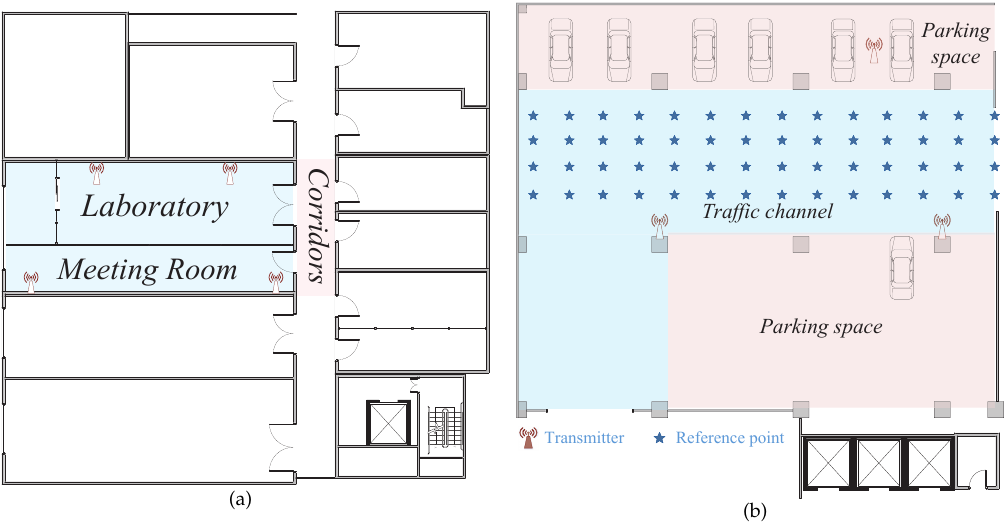
Figure 14. Experimental scenarios. ( a ) Integrated NLOS room. ( b ) Complex